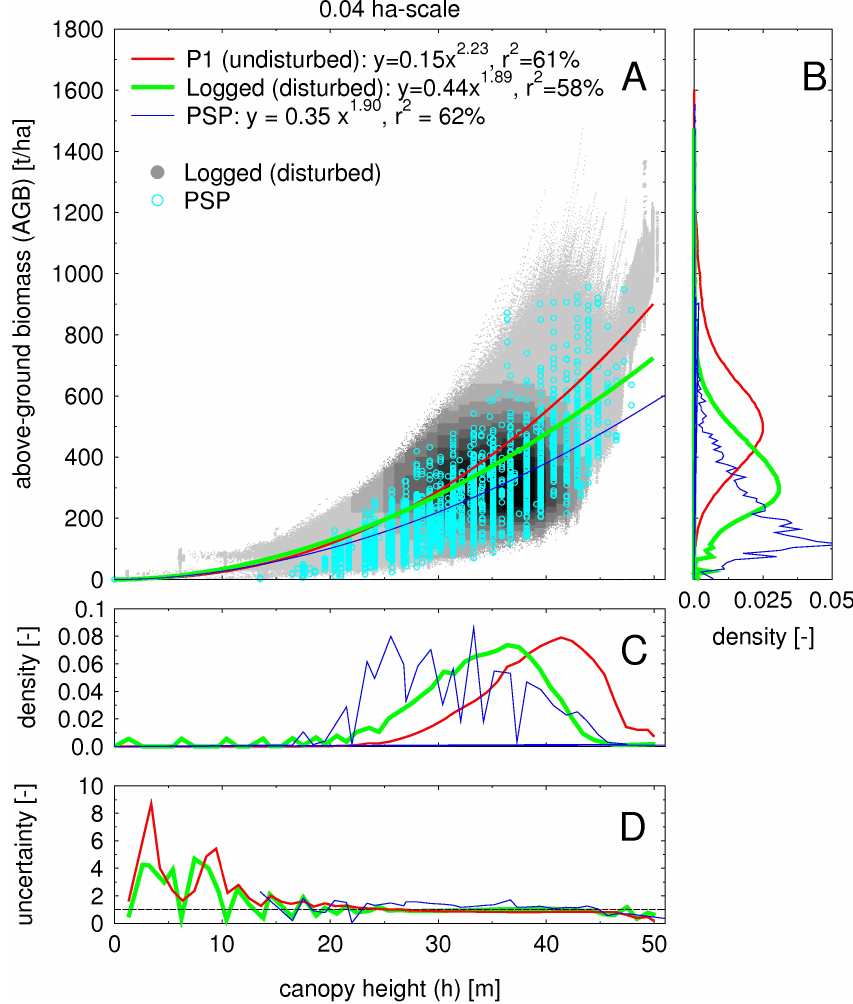
Fig. 4. Regression lines of above-ground life biomass (AGB) and canopy height ( h ) in 0.04ha-scale composition for the undisturbed forest (site P1), for disturbed forests (all 24 logging scenarios), and for permanent sampling plot data (PSP). The scatter plot of undisturbed (see Fig. 1) and disturbed forests are indistinguishable due to overlap and the data from the undisturbed site P1 are therefore omitted. Due to the huge number of data points in the scatter plot of the 0.04ha-scale (more than 14000000) the grey-scale indicates the density of the data points with highest densities in black. Normalised density of (B) AGB and of (C) h and relative uncertainty (D) on the 95% confidence level (4 σ /mean) are plotted for disturbed and undisturbed forest and PSP data, legend as on (A)